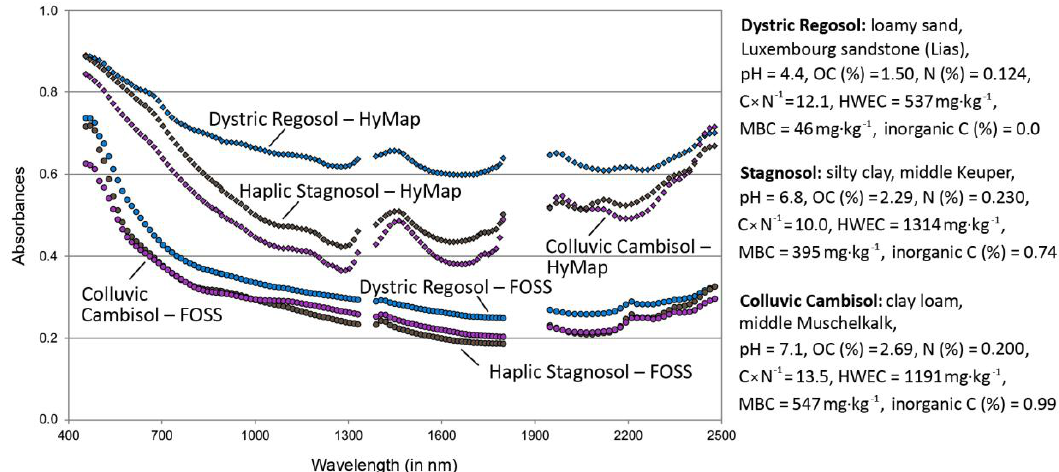
Figure 3. Examples of spectra measured for three plots in the laboratory (FOSS) and airborne (HyMap) (for clarification, FOSS spectra were shifted by −0.1 absorbances).